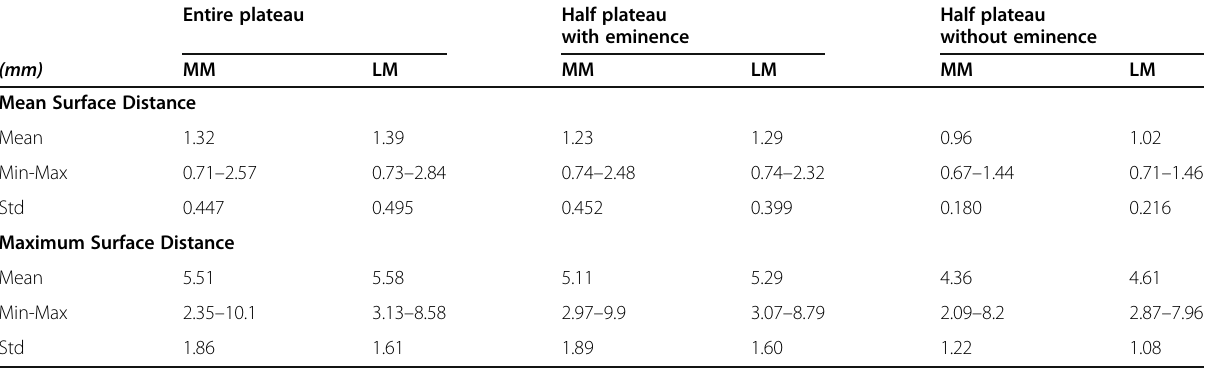
Table 1 3D-CT Sizing by entire and half tibia plateau Entire